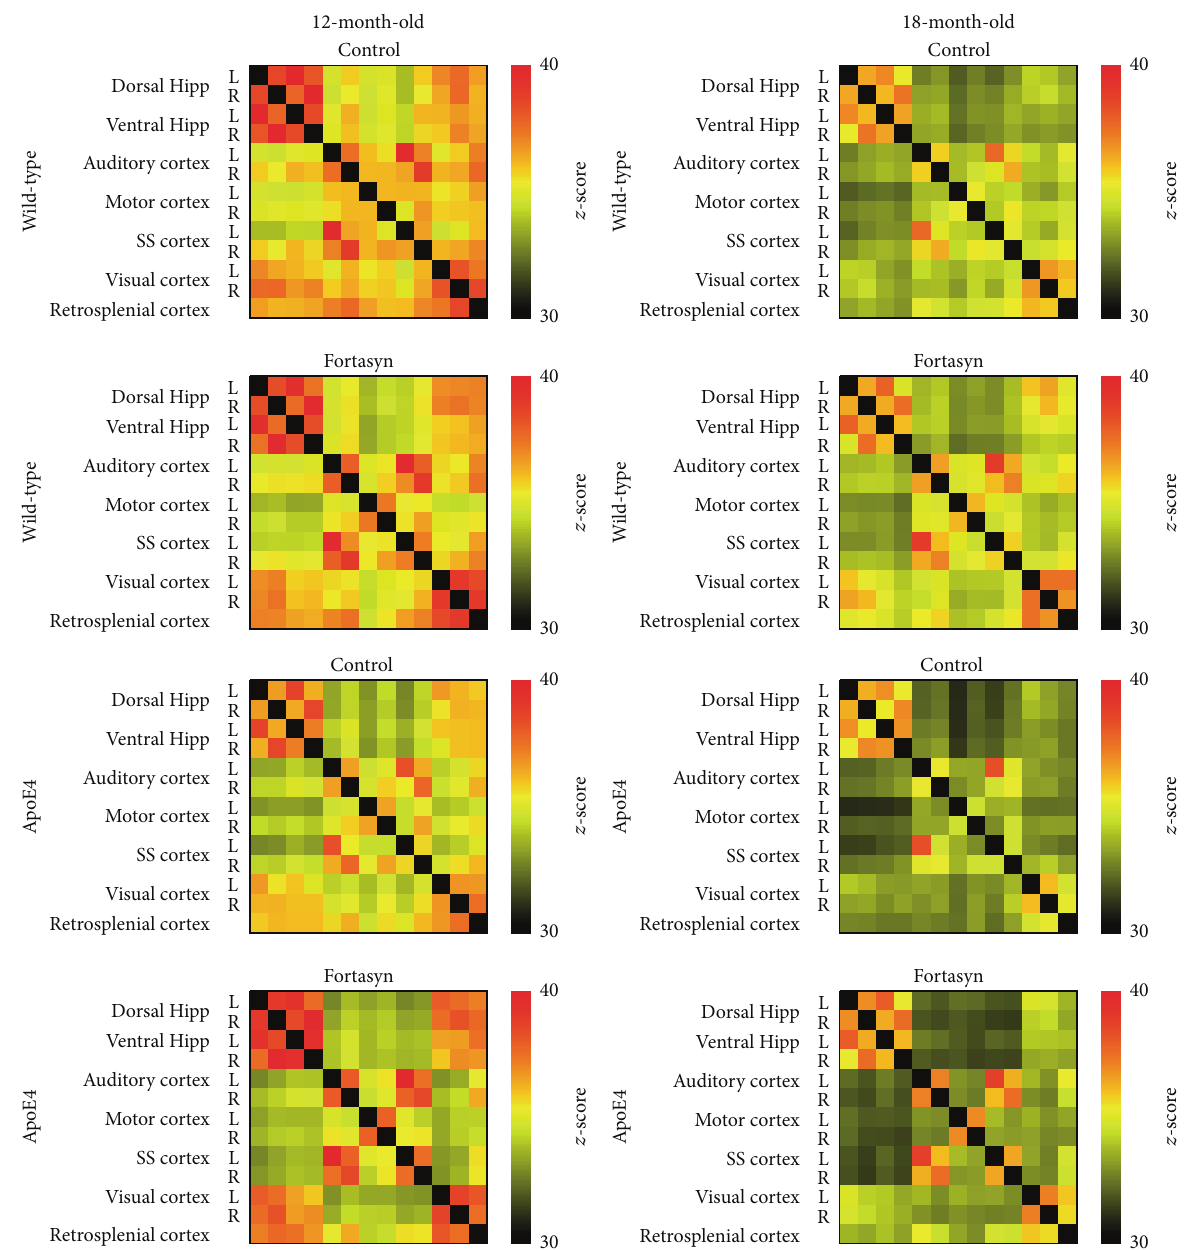
Figure 5: Resting-state functional connectivity (FC) based on total correlation analyses of 15 regions of interest (ROIs) in the mouse brain. Total correlation matrices of wild-type and apoE4 at 12 and 18 months of age, both on Fortasyn and control diets. At 12 months of age, multivariate ANOVA (MANOVA) revealed some significant genotype but no diet effects in apoE4 compared to wild-type mice. More specifically, apoE4 mice showed reduced FC between the right auditory cortex and the left dorsal hippocampus ( 𝑝 = 0.033 ) and also between the left visual cortex and the right auditory cortex ( 𝑝 = 0.028 ). At 18 months of age, apoE4 mice had significant lower FC between cortical and hippocampal regions but also between cortical regions themselves. Notably, Fortasyn was able to increase the hippocampal FC and also FC between the visual and retrosplenial cortices to the